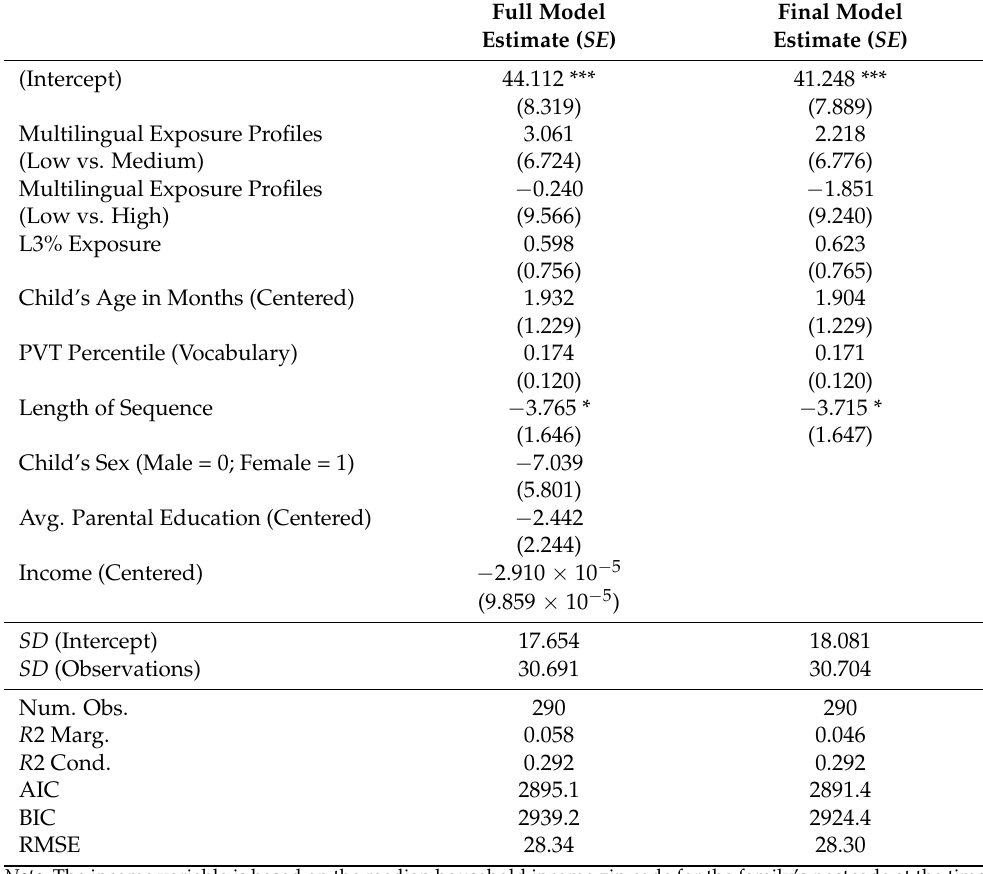
Table 7. Mixed Effects Models for Analysis Approach 3-Latent Profile